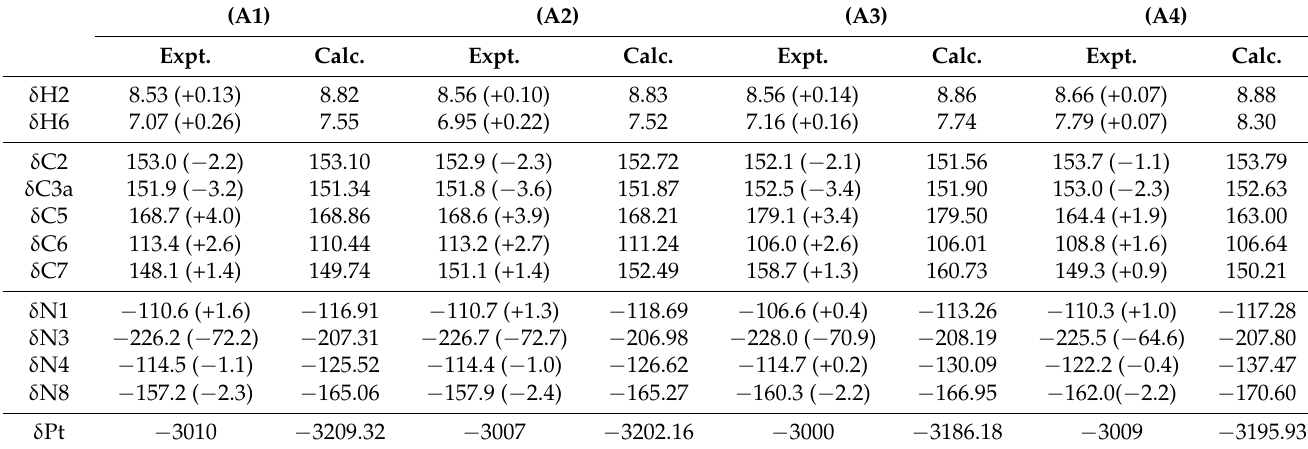
Table 3. Experimental and calculated 1 H, 13 C, 15 N, and 195 Pt NMR chemical shifts for selected atoms